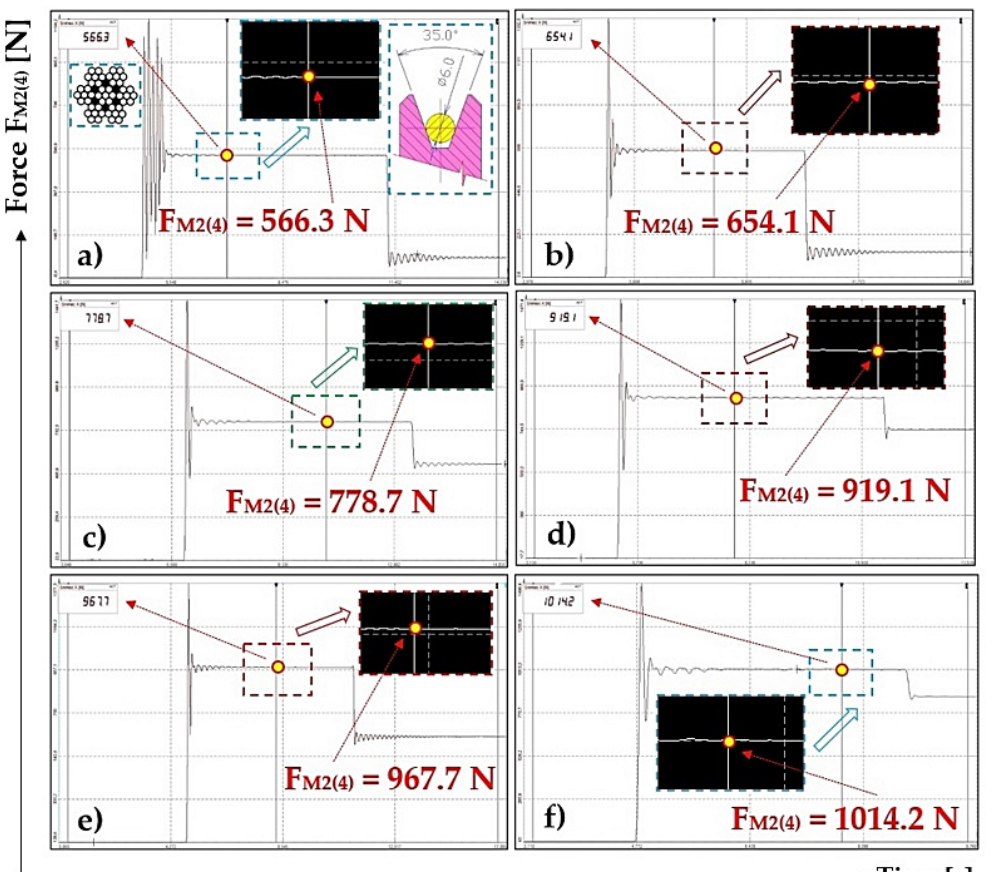
Figure 10e, 7f see Figure 10f.